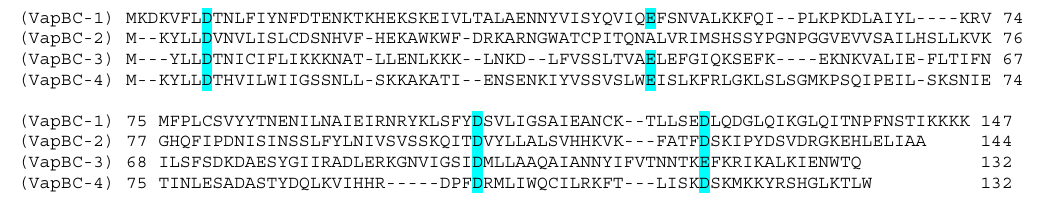
Figure 2. Alignment of the VapCs of L. interrogans serovar Copenhageni. Alignment was done using the COBALT tool (Constraint-based Multiple Alignment Tool), which aligns the sequences via considering the amino acid sequence and protein domains. The numbers of VapCs in parentheses are based on the numerical order of the genes in the chromosome and refer to the loci described in Table 1. The highlighted acidic amino acids comprise the residues essential to the catalytic activity and classification within the PIN (PilT N-terminal) domain.